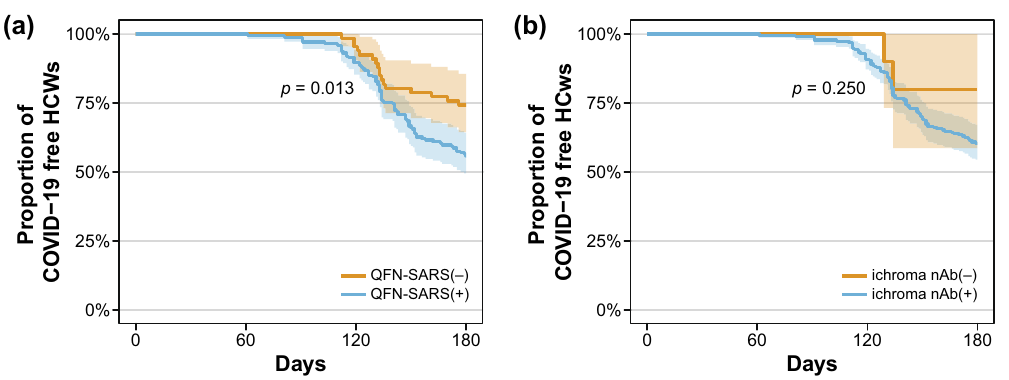
Figure 2. Kaplan–Meier plots of COVID-19-free follow-up days based on initial QFN-SARS results ( a ) and ichroma nAb results ( b ) for all enrolled